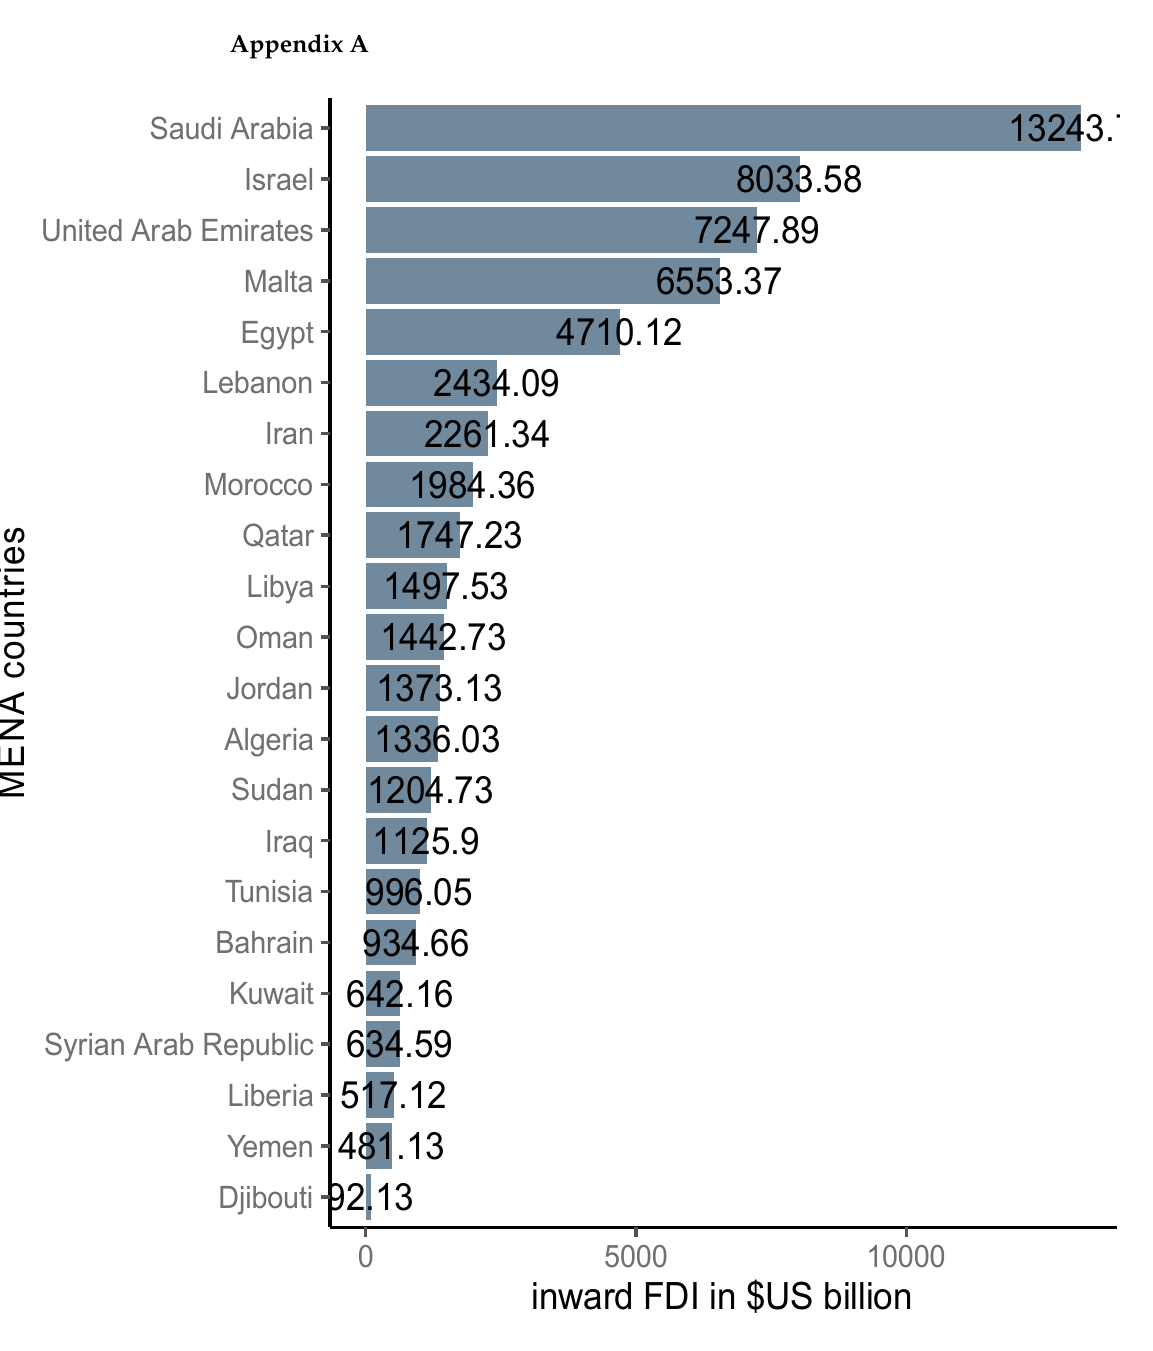
Figure A1. Average net FDI inflows to MENA countries, 1996 to 2019. Source: own summary.